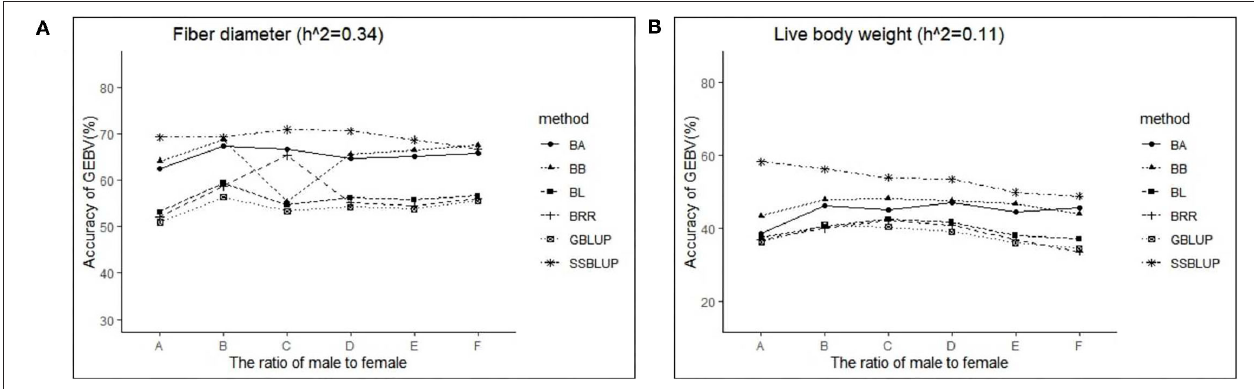
study were consistent with this point of view. Zhang et